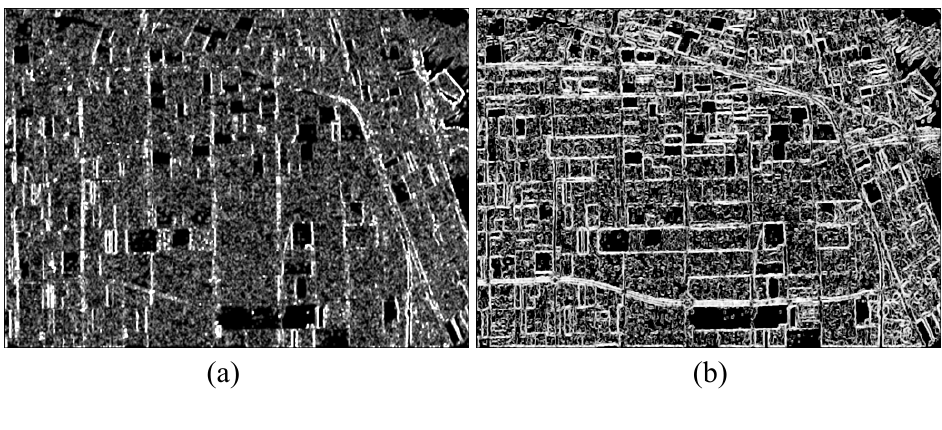
. ( a ) Contrast. ( b ) Correlation. ( c ) Energy. ( d ) 11